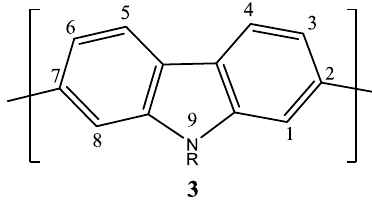
Figure 2. Poly (2,7-carbazole).